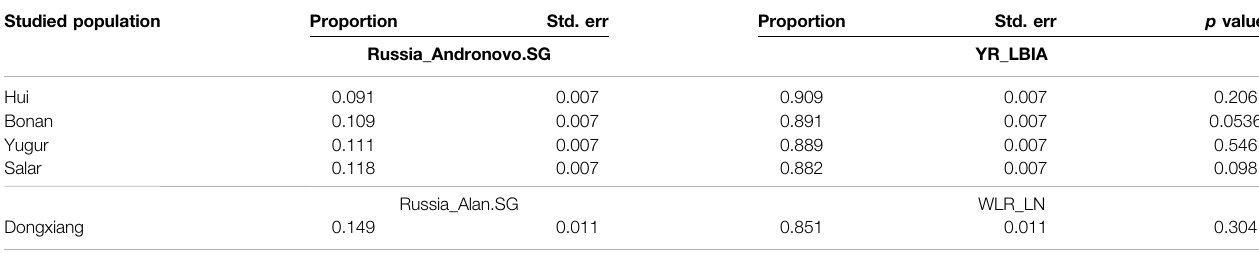
TABLE 2 | Two-way qpAdm models of studied populations in Gansu.